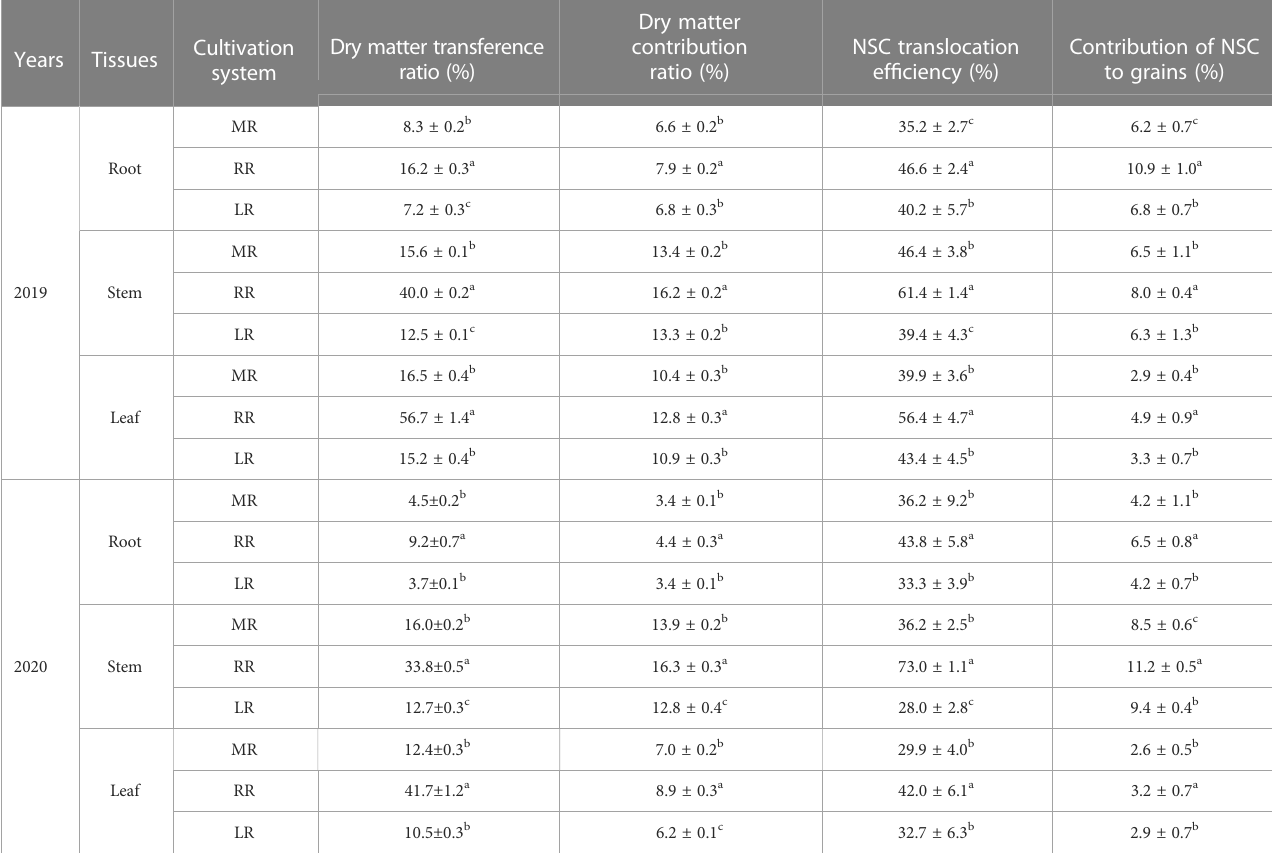
TABLE 1 Comparison of carbon reserve remobilization between early-season rice, ratoon rice, and late-season